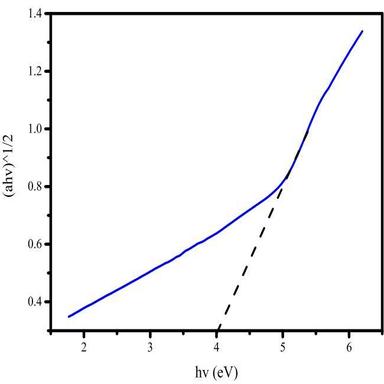
Tauc plot formed using absorption values of QD.